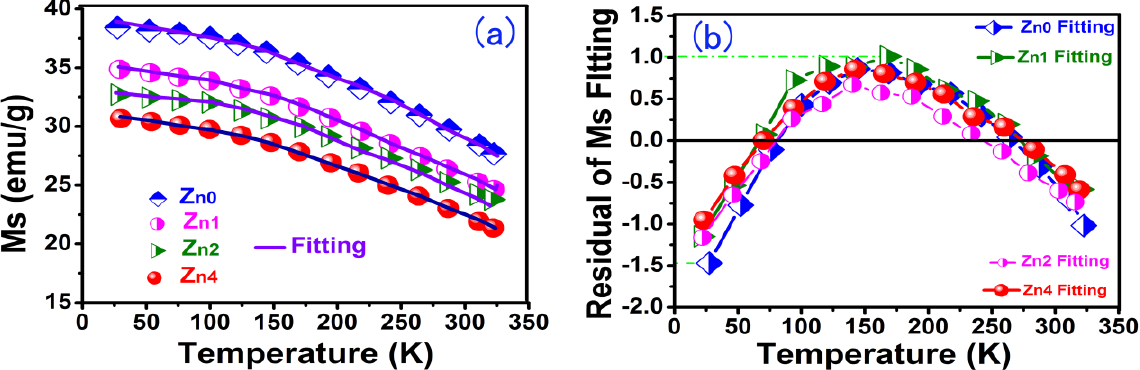
Figure 6. ( a )The temperature dependence of magnetic saturation for Zn — YIG samples and ( b )reg- Figure 6. ( a ) The temperature dependence of magnetic saturation for Zn—YIG samples and ( b ) regu- ular residual of fitting temperature dependence of magnetic saturation. lar residual of fitting temperature dependence of magnetic saturation.